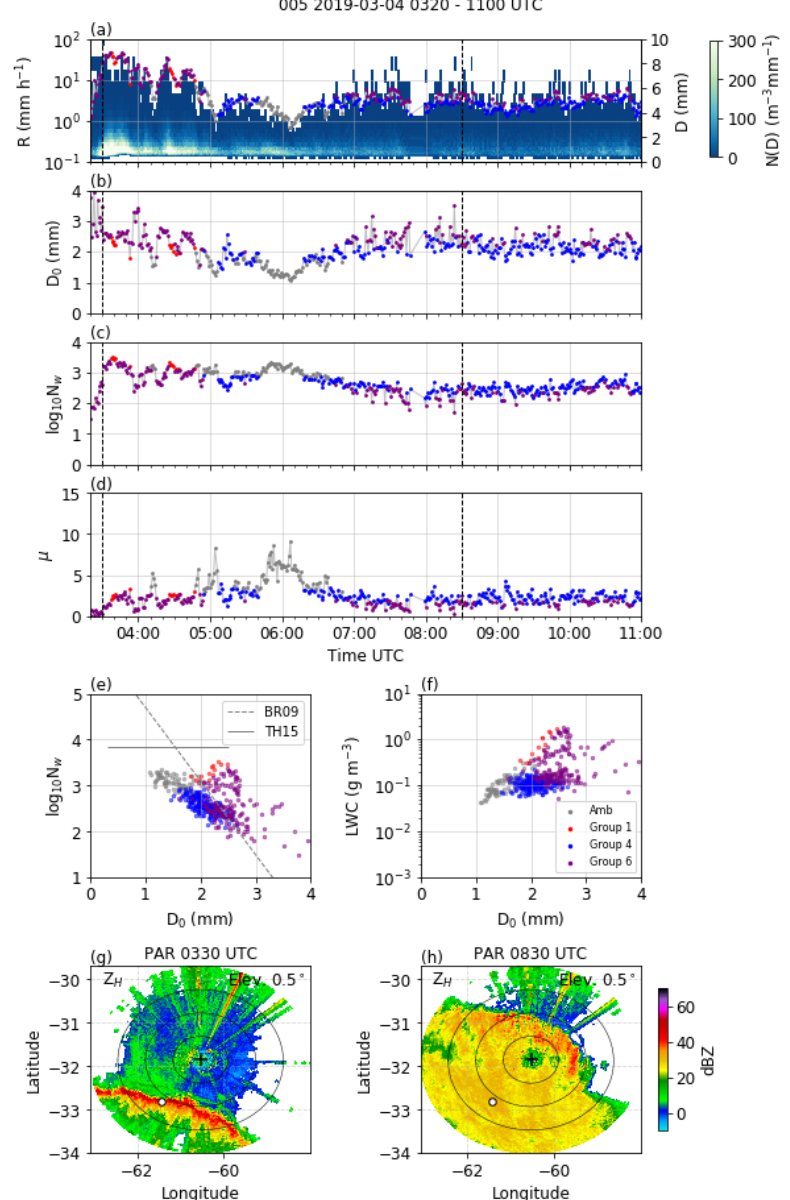
Figure 10. Temporal evolution of ( a ) R (dots) and N(D) (color shading), ( b ) D 0 , ( c ) log N w , and ( d ) µ as measured by disdrometer 005 on 4 March 2019 from 0320 to 1100 UTC. Projection of each 1 min DSD in the ( e ) log N w - D 0 and ( f ) LWC- D 0 parameter spaces. PPI of Z H measured by the PAR radar at ( g ) 0330 UTC and ( h ) 0830 UTC. The marker color in ( a – f ) indicates the group according to the D18 classification. Dashed lines in ( a – d ) mark the times of the radar images. The rings in ( g , h ) indicate the 60, 120, and 180 km ranges. The white marker shows the position of the